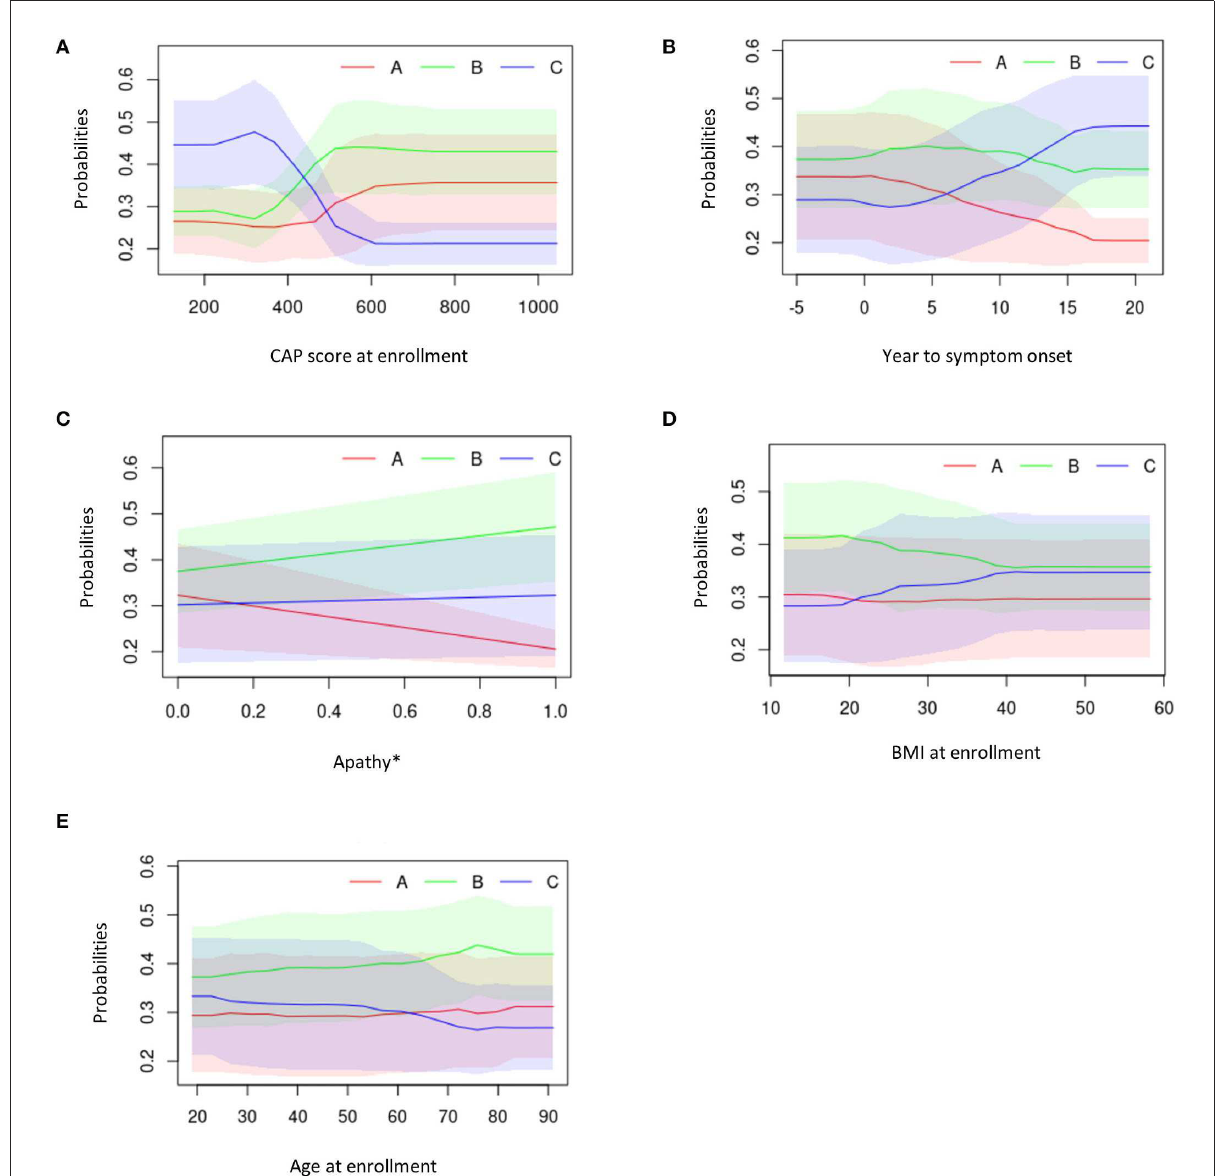
FIGURE7 Partial dependency plots describing the top five predicting features against average cluster probability (y-axis). (A) CAP score at enrollment. (B) Years to symptom onset. (C) Apathy. (D) BMI at enrollment. (E) Age at enrollment. *0 = No; 1 = Yes. BMI, body mass index; CAG, cytosine adenine guanine; CAP, CAG-age